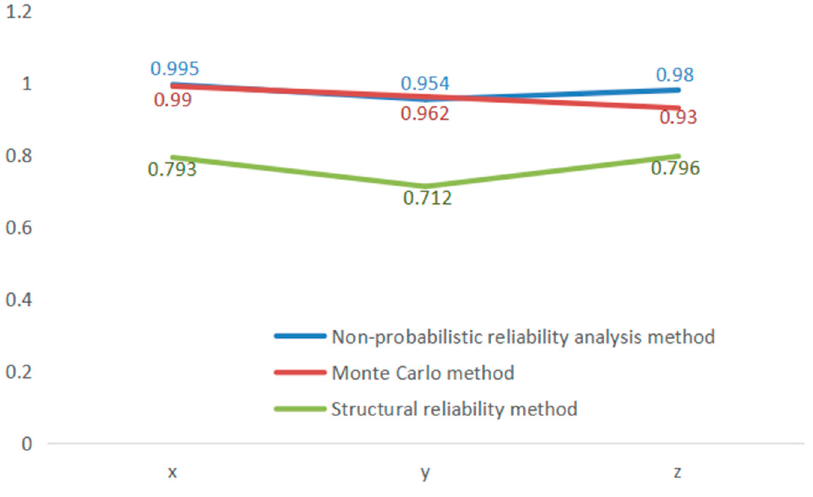
Figure 18. Motion reliability of robot end effector.